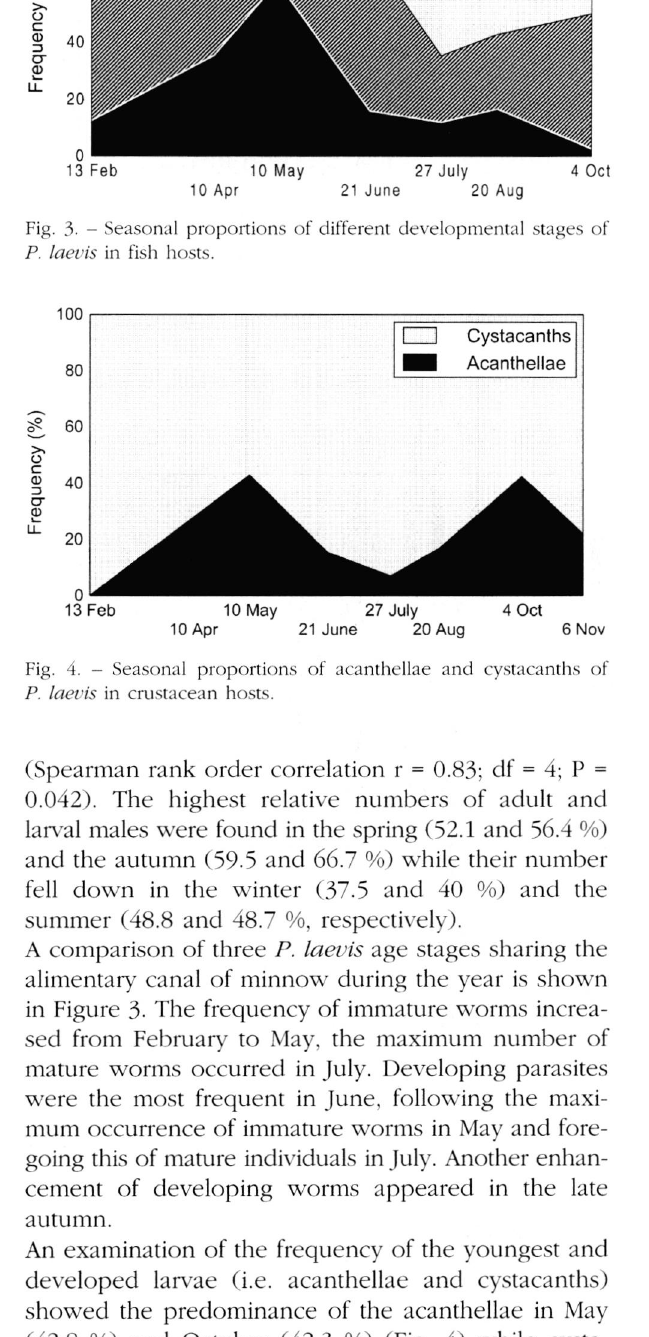
Fig. 2. - Frequency distribution of P. laevis larvae in intermediate crustacean hosts.